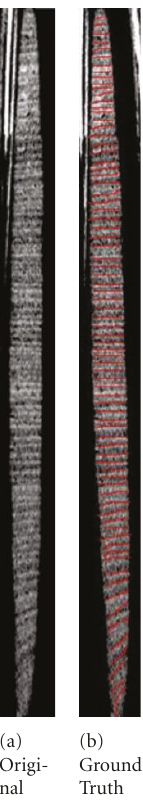
Figure 11: Results using uniform wavelength spacing filterbank specificationsfor a Populussample:(a)originalimage,(b) manually segmented ground truth, (c) FM image after application of uniform spacing filterbank. The ground truth for this sample is 79